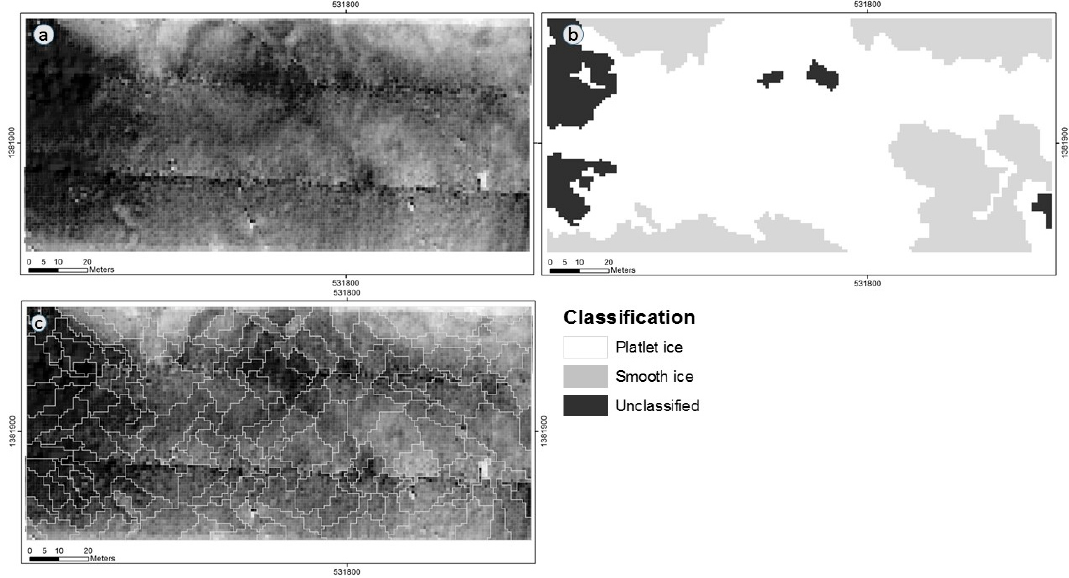
backscatter can be clearly seen (zoomed in).